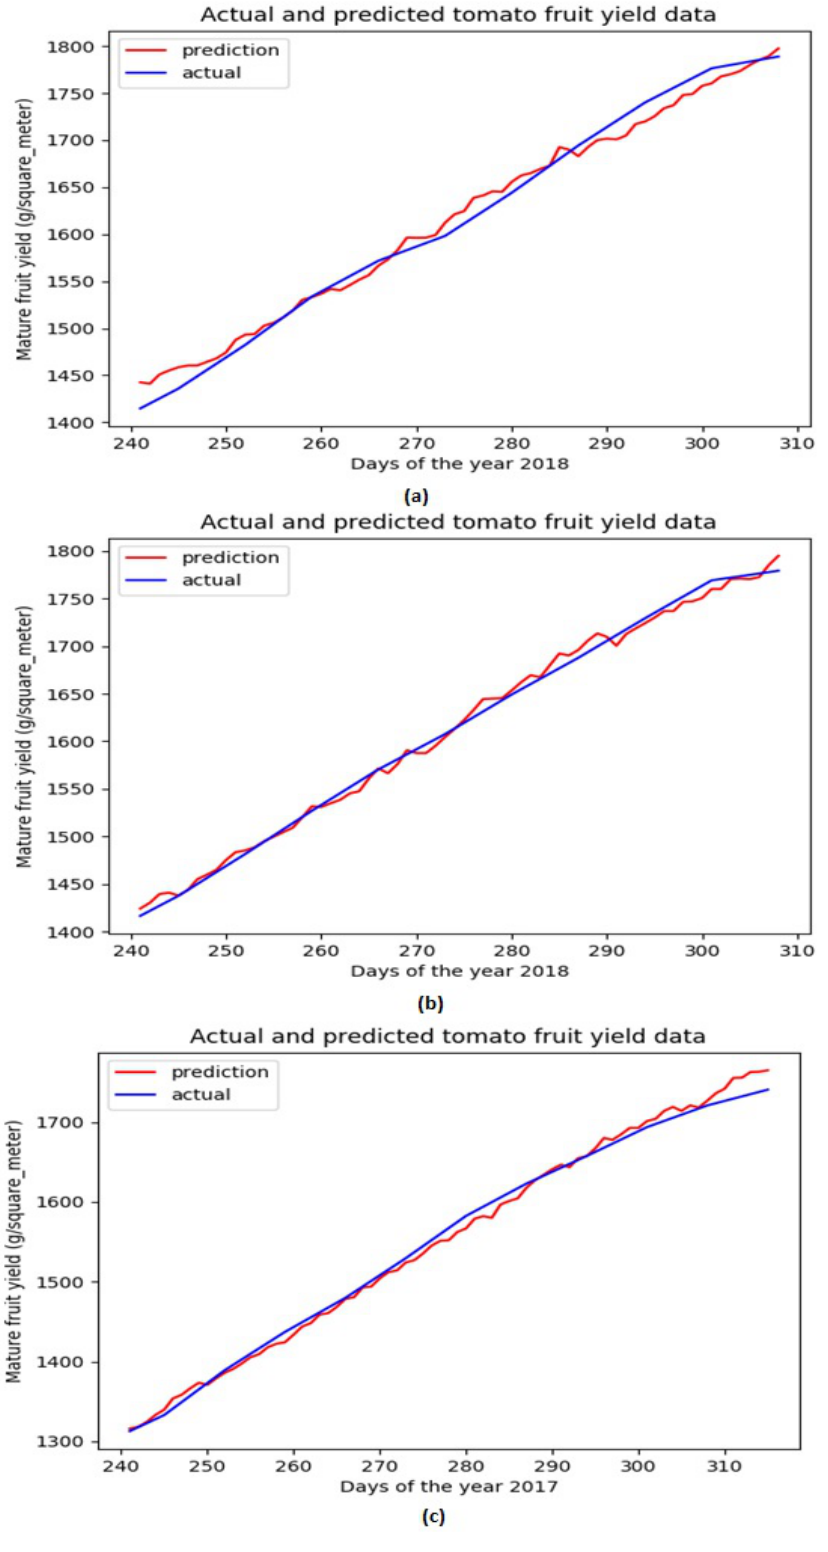
Figure 5. Ground truth tomato fruit yield values and predicted ones for testing datasets associated with Dataset 1 ( a ) Dataset 2 ( b ) Dataset 3 ( c